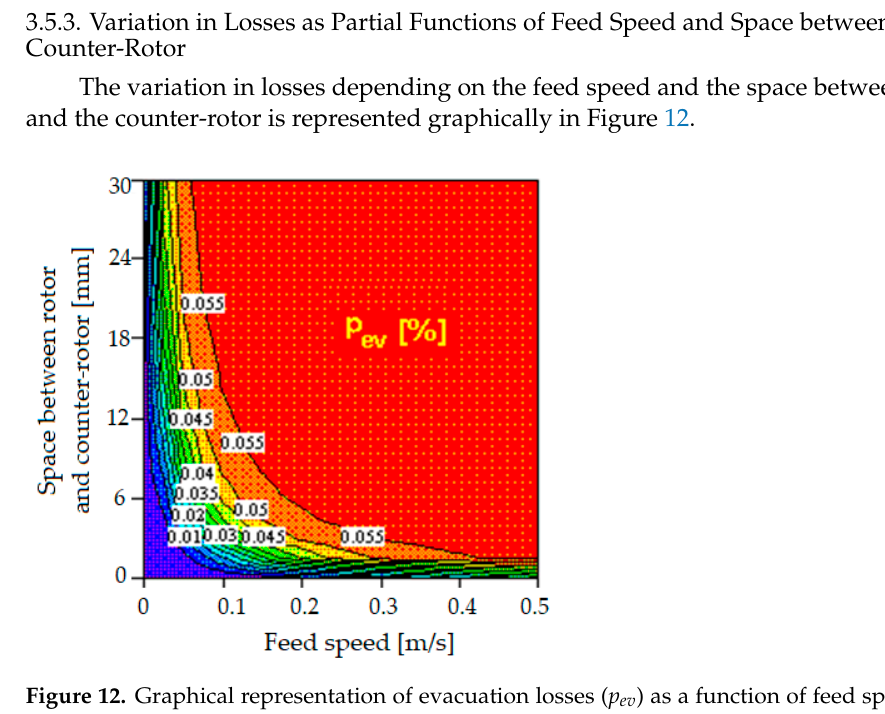
Figure 11. Graphical representation of the evacuation losses ( p ev ) as a function of rotor peripheral speed ( v p ) and space between the rotor and the counter-rotor ( δ ). speed ( v p ) and space between the rotor and the counter-rotor ( δ ).